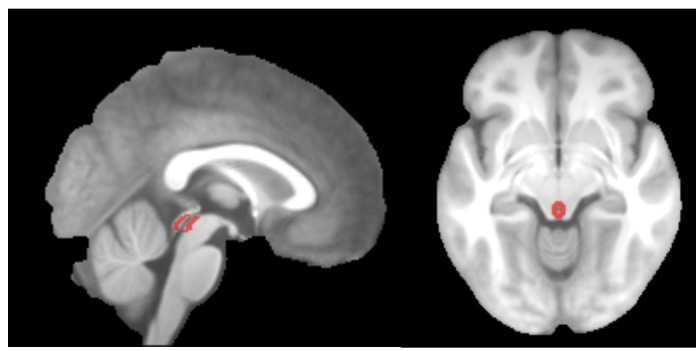
PAG mask overlaid on the group-mean structural image.